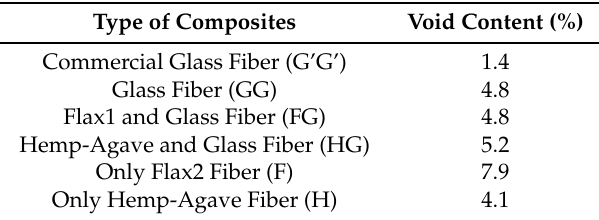
Table 3. The void content of flax, hemp-agave, and glass fiber reinforced composites.